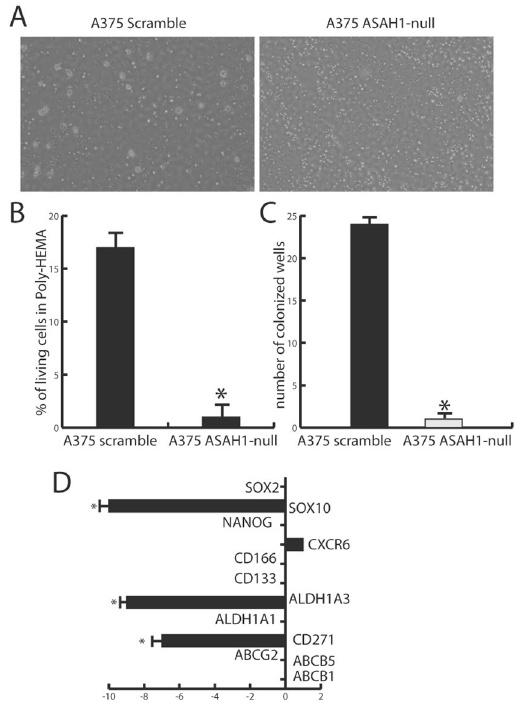
Figure 6. AC deletion suppresses cancer-initiating cell formation and self-renewal. ( A ) Cancer-initiating cell formation on Poly-HEMA-coated plates and vitality assays in control (scramble-treated, left) and ASAH1 -null A375 cells (right). ( B ) Viability of cells in Poly-HEMA plates. * p < 0.05, ** p < 0,01, *** p < 0.001; Student’s t test. ( C ) Self-renewal assay in control (scramble-treated) and ASAH1 -null A375 cells: no wells were colonized by ASAH1 -null cells indicating suppression of self-renewal capabilities. * p < 0.05, ** p < 0,01, *** p < 0.001, Student’s t test. ( C ) Real-time PCR showing downregulation of SOX10 , which is consistent with the observed downregulation of MITF . Two crucial genes related to cancer initiating cells formation and metabolism